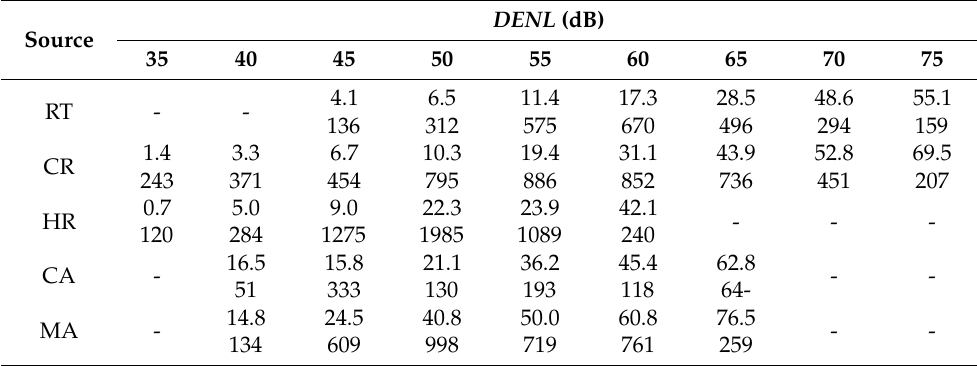
Table 8. Observed %HA and sample size of DENL by transportation noise. Values in each cell are as follows: top, %HA; bottom, sample size.